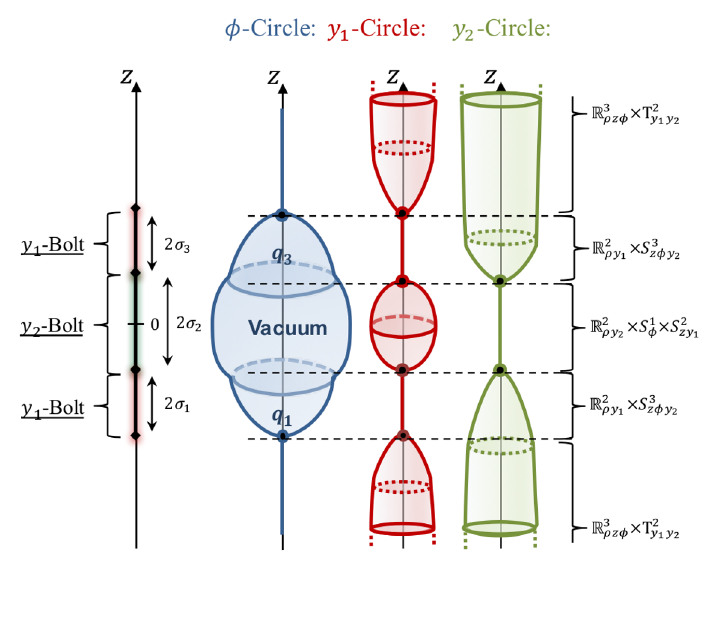
Figure 12 . Schematic description of the smooth three-bubble configuration and the behavior of the φ , y 1 and y 2 circles on the z